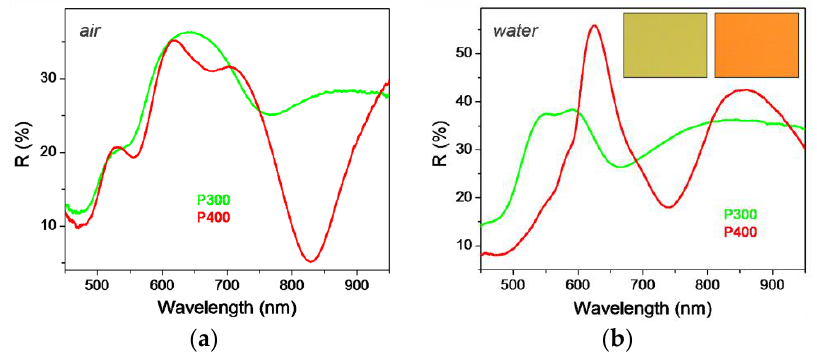
Figure 4. Optical reflectivity spectra of nanopost arrays: ( a ) in air and ( b ) in water. The insets show optical images of the nanopost arrays having the lattice parameter P as indicated on the